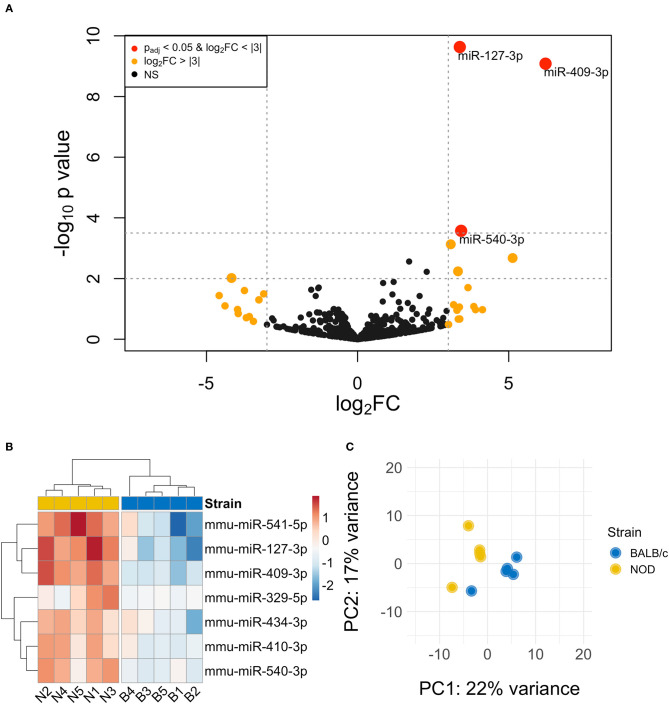
Differential miRNA expression analysis. (A) The volcano plot highlights miRNAs that were identified in exosomes isolated by differential ultracentrifugation as upregulated or downregulated by more than 3-fold, shown in orange. Upregulated miRNAs that are statistically significantly different are shown in red. (B) Unsupervised hierarchically clustered heatmaps of the most differentially expressed miRNA (with highly expressed miRNAs in red and minimally expressed miRNAs in blue) in the 10 samples. Samples are labeled either N for NOD or B for BALB/c. Individual samples for the top differentially expressed miRNA cluster by strain. (C) PCA plot of all miRNAs shows that 22% of the variance was accounted for by strain.